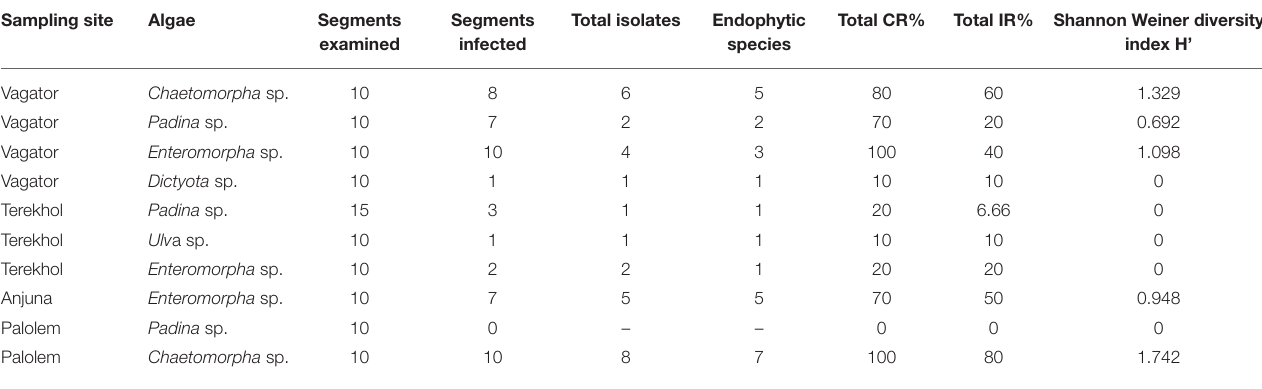
TABLE 1 | Endophytic isolates from marine algae collected from Konkan coast, India. Sampling